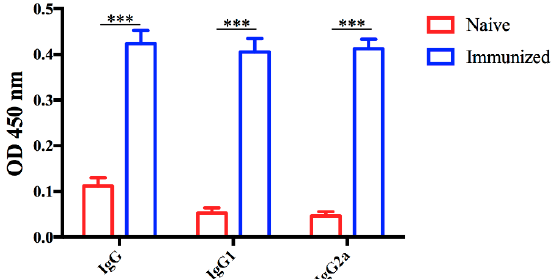
Figure 4. Serum antibody levels in mice vaccinated with RH ∆ gra17 ∆ npt1 . The levels of total IgG and IgG isotypes (IgG1 and IgG2a) were determined in the serum of Kunming mice vaccinated with RH ∆ gra17 ∆ npt1 . Analysis was performed by using ELISA at 60 days post-vaccination. Results are expressed as mean of OD 450 ± SD, and level of significance was compared to control naïve mice (***, p < 0.001).